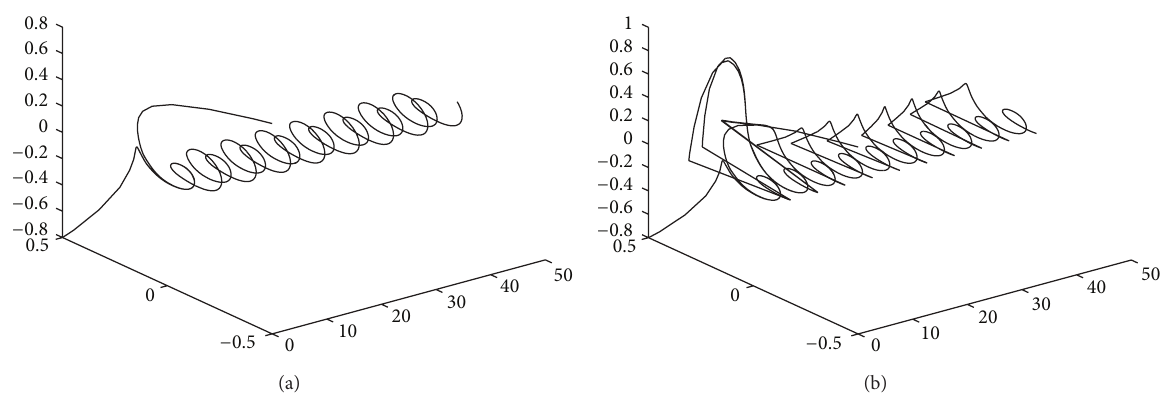
Figure 3: (a) Phase plot in space (𝑡,𝑥 1 , 𝑥 2 ) , (𝑡,𝑢 1 , 𝑢 2 ) without impulsive effects. (b) Phase plot in space (𝑡,𝑥 1 , 𝑥 2 ) , (𝑡,𝑢 1 ,𝑢 2 ) with impulsive